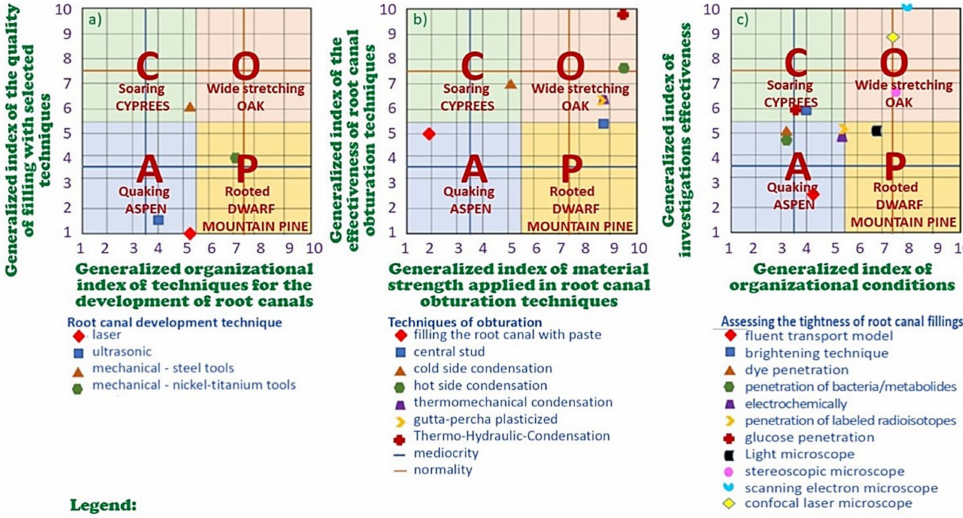
Figure 5. Contextual matrices: ( a ) root canal development technique selection; ( b ) selection of the techniques of obturation; ( c ) selection of the methods of assessing the tightness of root canal